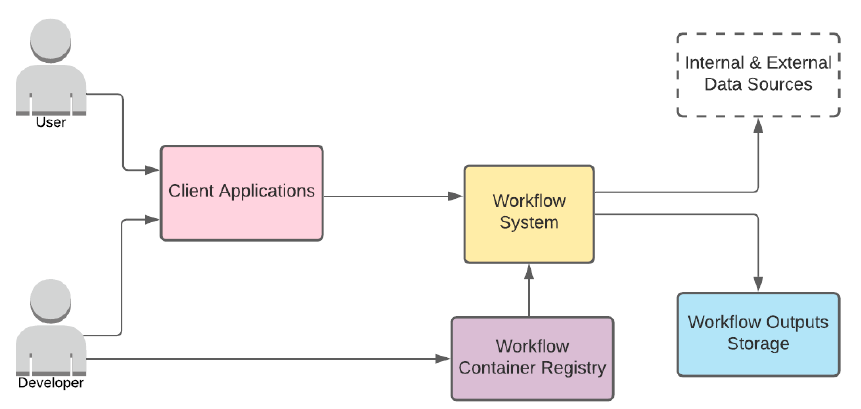
Figure 5. High-level system components and roles.